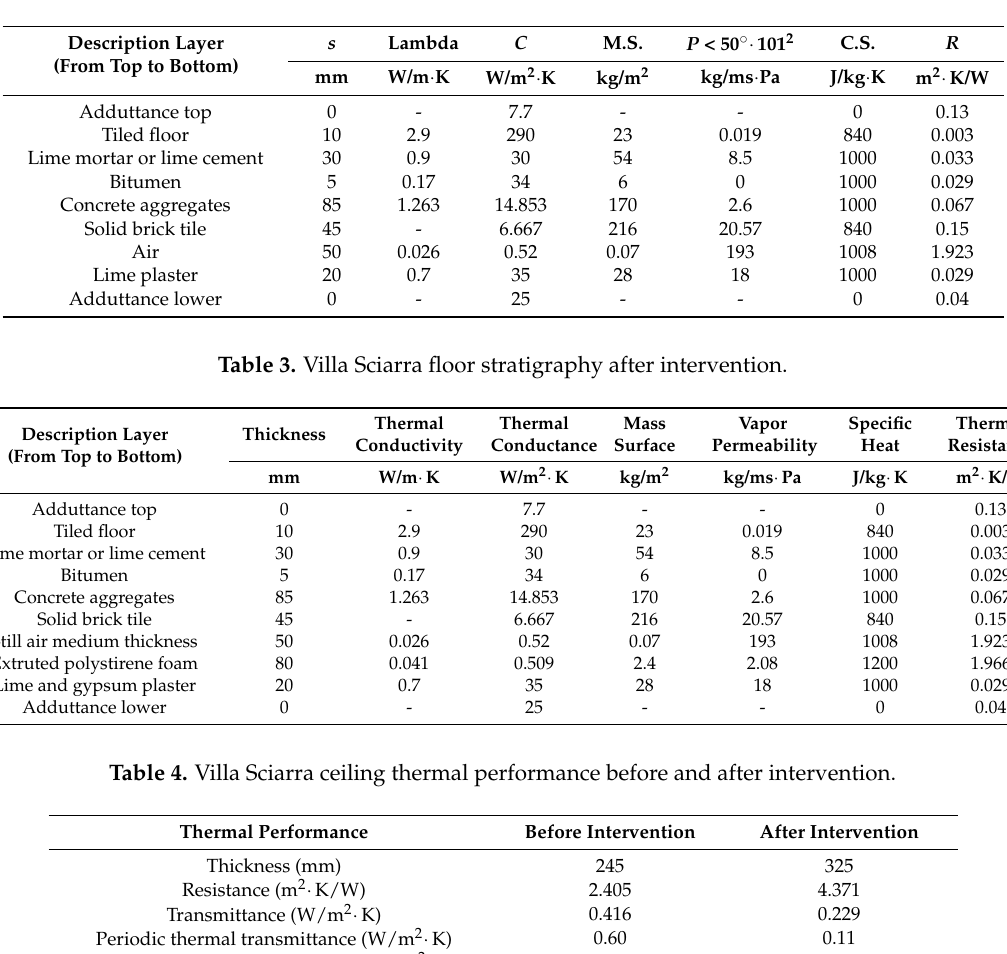
Table 2. Villa Sciarra floor stratigraphy before intervention.